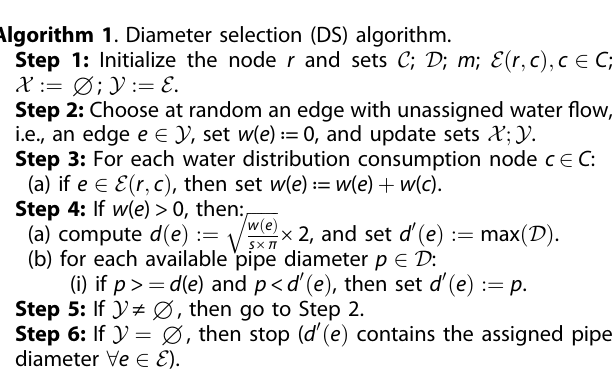
Algorithm 1 . Diameter selection (DS) algorithm. Step 1: Initialize the node r and sets C ; D ; m ; Eð r ; c Þ ; c 2 C ;